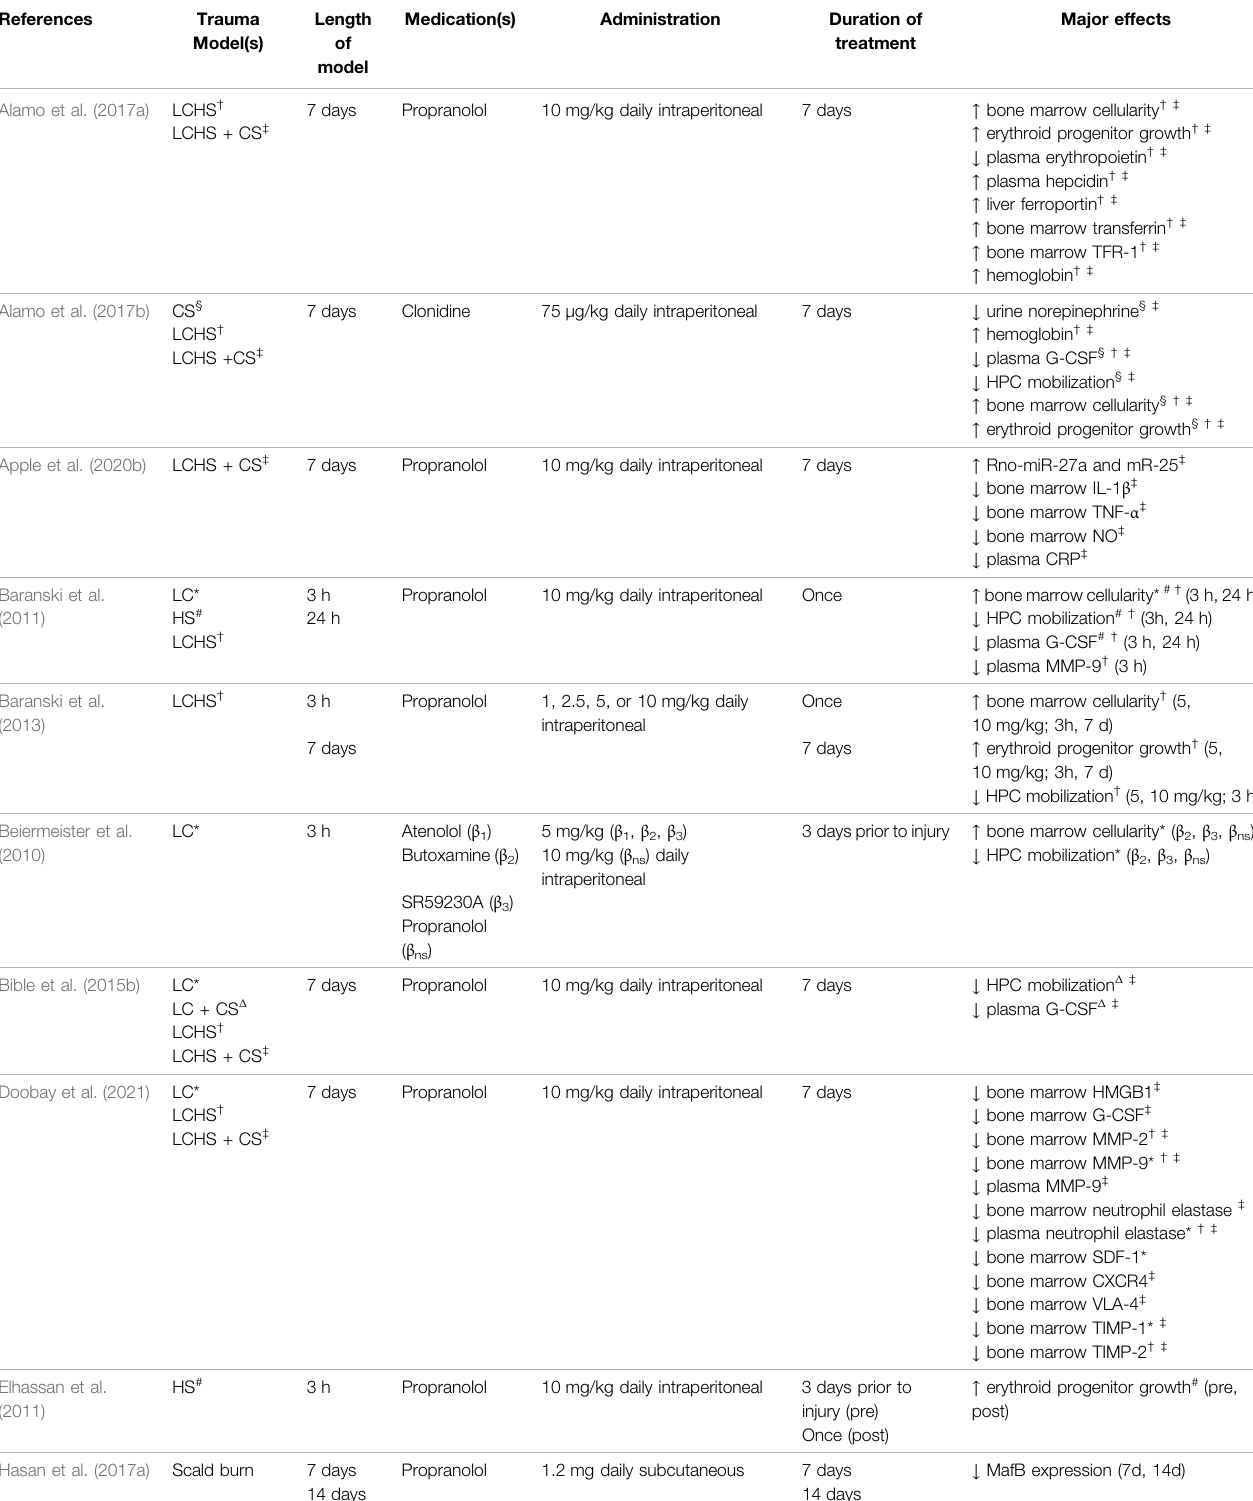
TABLE 1 | Major studies of adrenergic modulation of erythropoiesis in rodents (rats or mice) who were subject trauma. Major effects demonstrate signi fi cant changes (increased or decreased) represented by arrows compared to untreated